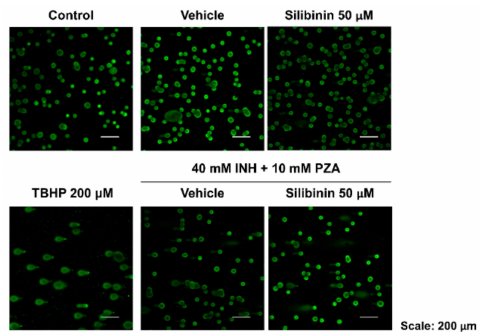
Figure 3. Silibinin reduced reactive oxygen species (ROS) levels and oxidative damage when co-administered with a combination of isoniazid (INH) and pyrazinamide (PZA). Positive controls were treated with the oxidising agent tert-butyl hydroperoxide (TBHP) 200 µ M for 2 h. To avoid excessive hepatocyte death, the concentrations of INH and PZA were limited to 40 mM and 10 mM, respectively, when treated in combination (I / P 40 / 10) over 24 h. ( A ) 50 µ M silibinin reduced intracellular ROS levels (t-test, p = 0.0466). ( B ) Silibinin decreased carbonylation levels, a marker of oxidative damage in proteins, at 25 µ M (one-way ANOVA, p = 0.0015) and 50 µ M (one-way ANOVA, p = 0.0023). ( C ) Silibinin reduced lipid peroxidation levels as measured by the thiobarbituric acid reactive substances (TBARS) assay at 25 µ M (one-way ANOVA, p < 0.0001) and 50 µ M (one-way ANOVA, p = 0.0007). ( D ) Silibinin’s reduction of ROS levels at 50 µ M was independent of DNA oxidative damage reduction as visually assessed, and as measured quantitatively by tail moment and olive moments. Administration of silibinin alone did not trigger DNA fragmentation. Data represent mean ± S.E.M. of at least two replicates. * p < 0.05, ** p < 0.01, *** p < 0.001 vs. vehicle control co-administered with I / P 40 /